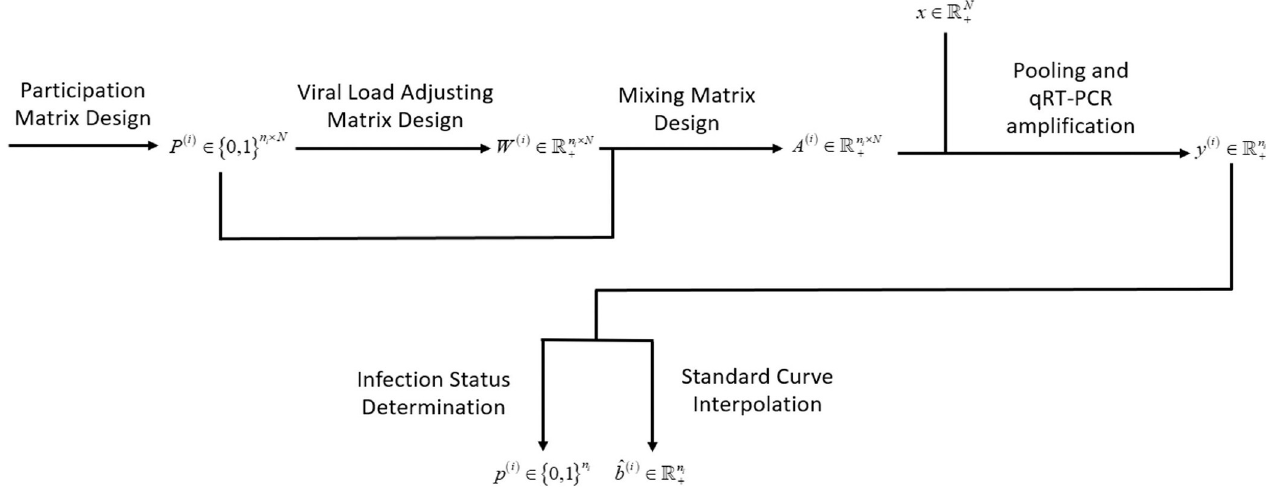
Fig 1. Mathematical framework for pooling in the i -th stage in a multiple-stage pooling strategy.